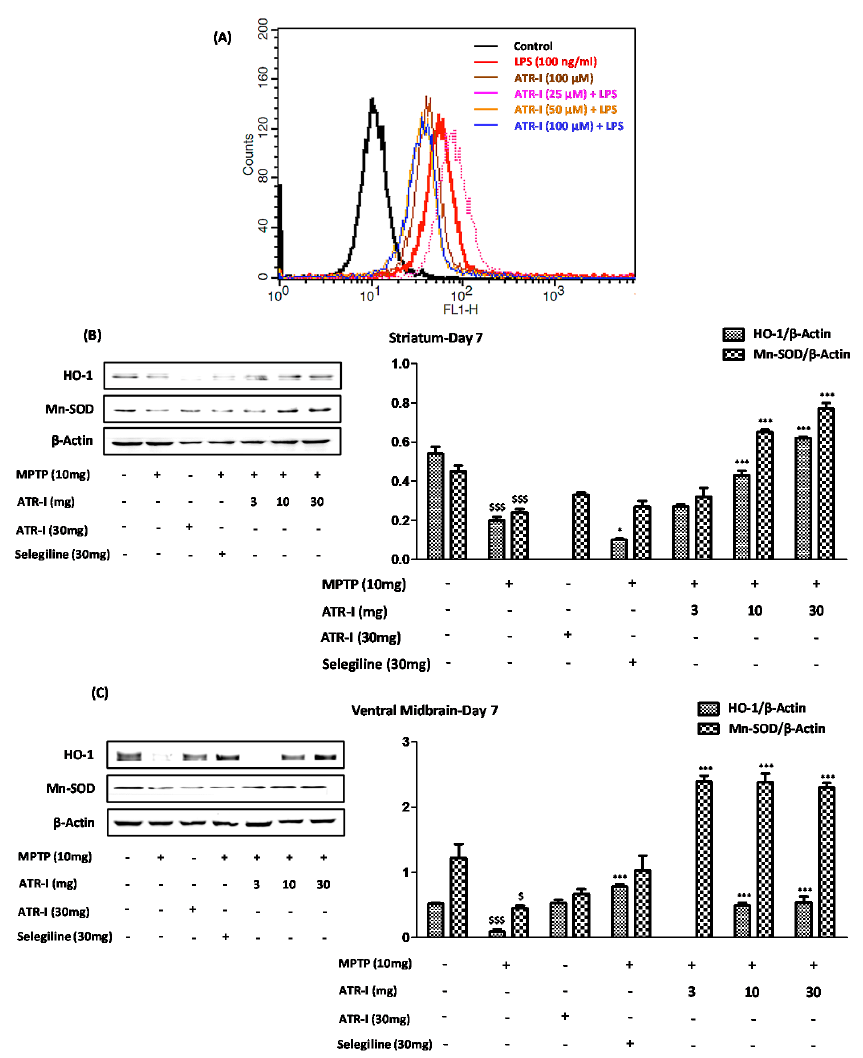
Figure 6. ( A ) The histogram obtained by fluorometric analysis portrays one representative set of results ( n = 6) from the three different experiments in BV-2 cells; ( B ) Represents protein levels for HO- 1 and MnSOD in STR and ( C ) VM. A densitometric analysis of HO-1 and MnSOD is shown in the right panel. $ p < 0.05 and $$$ p < 0.001 vs. vehicle group; * p < 0.05 and *** p < 0.001 vs. MPTP-treated